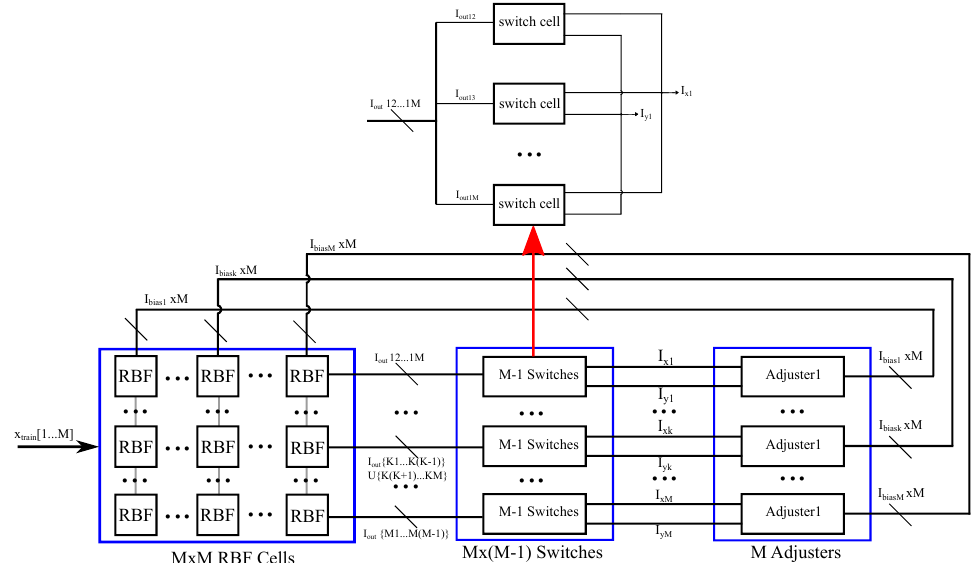
Figure 2. An illustration of the learning block. The RBF cells receive the learning samples and output the multivariate RBF kernel. The input labels are imported to the training circuit via the following switches. The adjusters implement the min and max